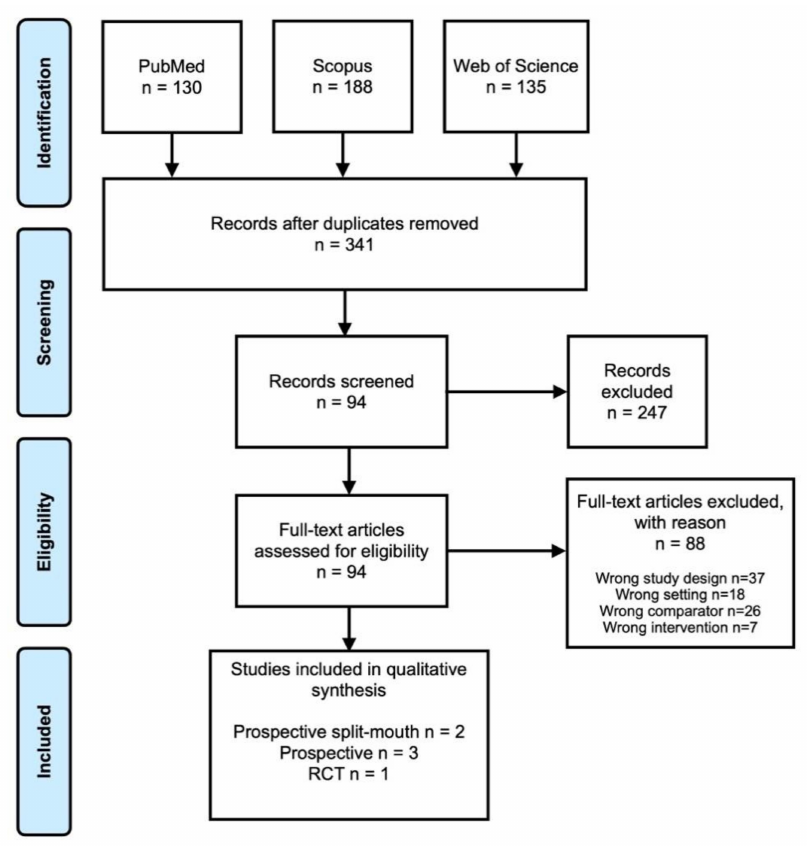
Figure 1. Prisma